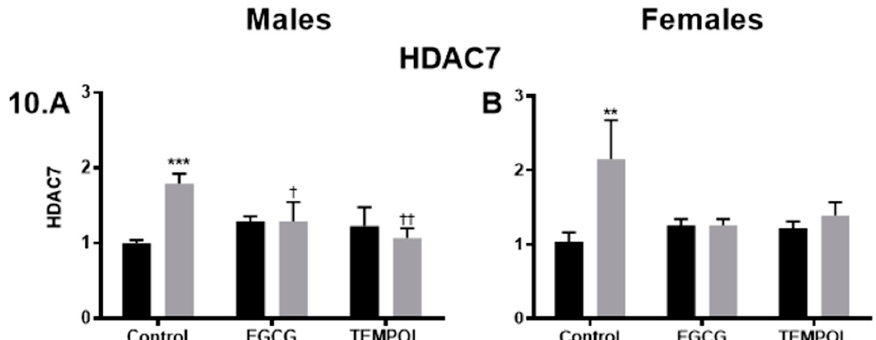
Figure 10. HDAC7 gene expression results from the RT 2 profiler array (Qiagen). Histone deacetylase (HDAC) 7 ( A , B ) gene expression results for males and females, respectively. Saline and Dex control have been published previously and have been provided for reference [7]. Statistical analysis was performed using a two-way ANOVA (Fisher’s LSD test) shown as † p = 0.05, **/†† p = 0.01, *** p = 0.001. Data are presented as mean ± SEM. Comparison to the Control-Saline group is represented with the symbol (*) and (†) for the Control-Dex offspring. n = 3–5 per group. Significant interactions between maternal injection and antioxidant administration were found for HDAC7